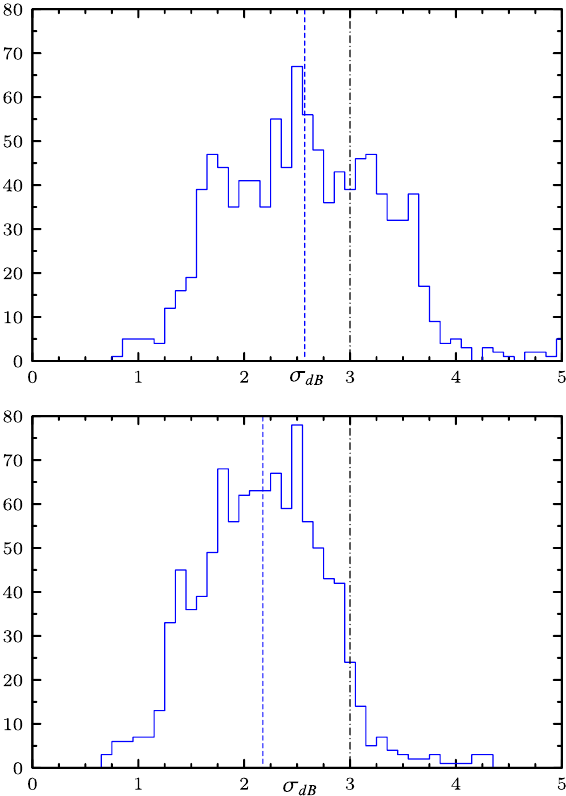
Figure 8: Histograms of values of σ dB experimentally ob- tained in the two configurations of the RC shown in Fig. 7. Also shown: the limit at 3dB (black dash-dots) and the mean of σ dB (blue dashes). Above: histogram for the con- ventional RC with the stirrer ( (cid:104) σ dB (cid:105) = 2 . 57 ). Below: his- togram for the chaotic RC with 3 half-spheres and the stirrer ( (cid:104) σ dB (cid:105) = 2 . 18 ).